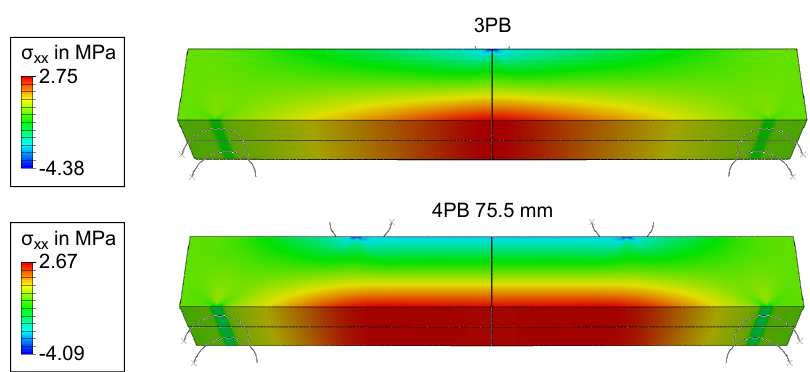
Figure 10. The FEM results show the stress in the x -direction of 3PB (top) and 4PB 75.5 mm (bottom), which were used for the calculation of the effective volume.